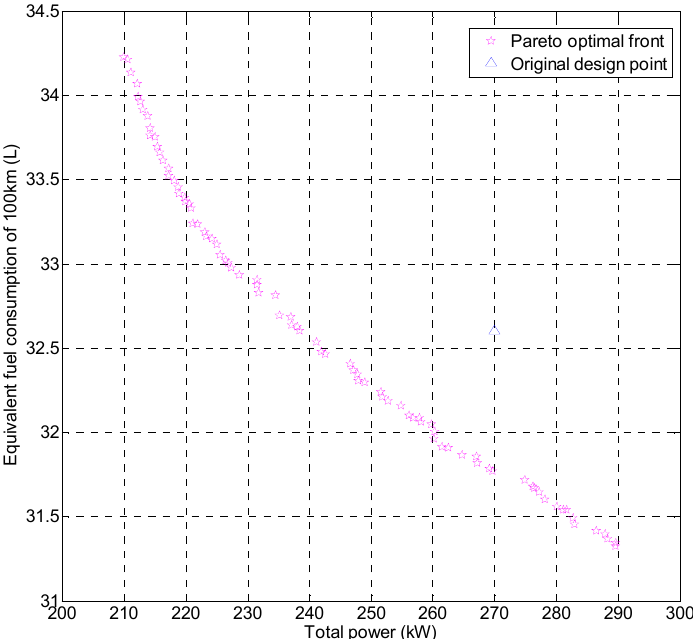
Figure 10. Multi-objective optimization results considering lightweight and fuel economy.